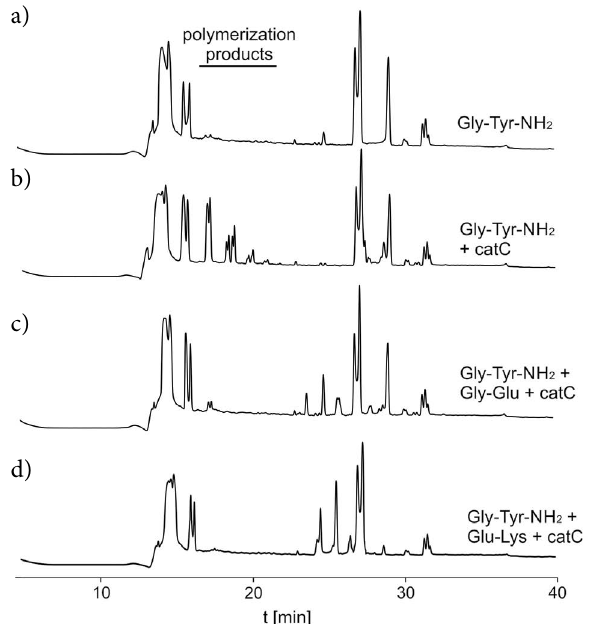
Figure 3. Gly-Glu, the prodipeptide from granzyme B, inhibits the transferase and the peptidase activity of cathepsin C. (a) The dipep- tide Gly-Tyr-NH 2 as a control sample. (b) Polymerization of Gly- Tyr-NH 2 by cathepsin C (catC) using a reverse phase HPLC. The products of polymerization are eluted with a retention time 15–20 minutes. Dipeptides Gly-Glu (b) and Glu-Lys (c) inhibit polymeri- zation reaction of Gly-Tyr-NH 2 by catC.